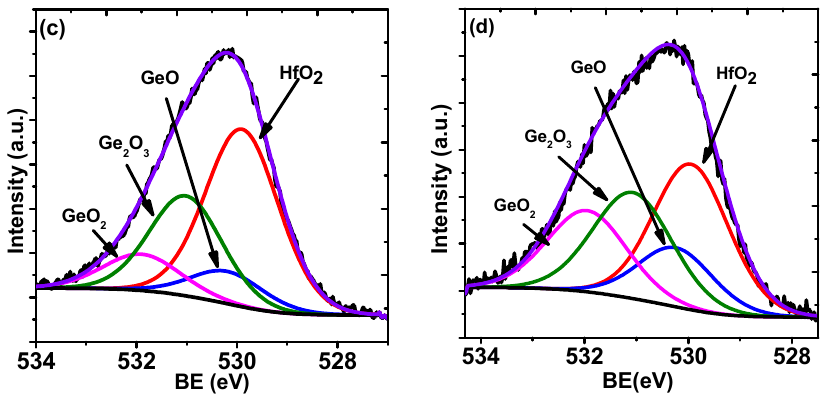
Figure 5. O 1s spectra from 5 nm films of: ( a ) TiO 2 ; ( b ) Ti 0.9 Hf 0.1 O 2 ; ( c ) Ti 0.25 Hf 0.75 O 2 ; and ( d ) HfO 2.